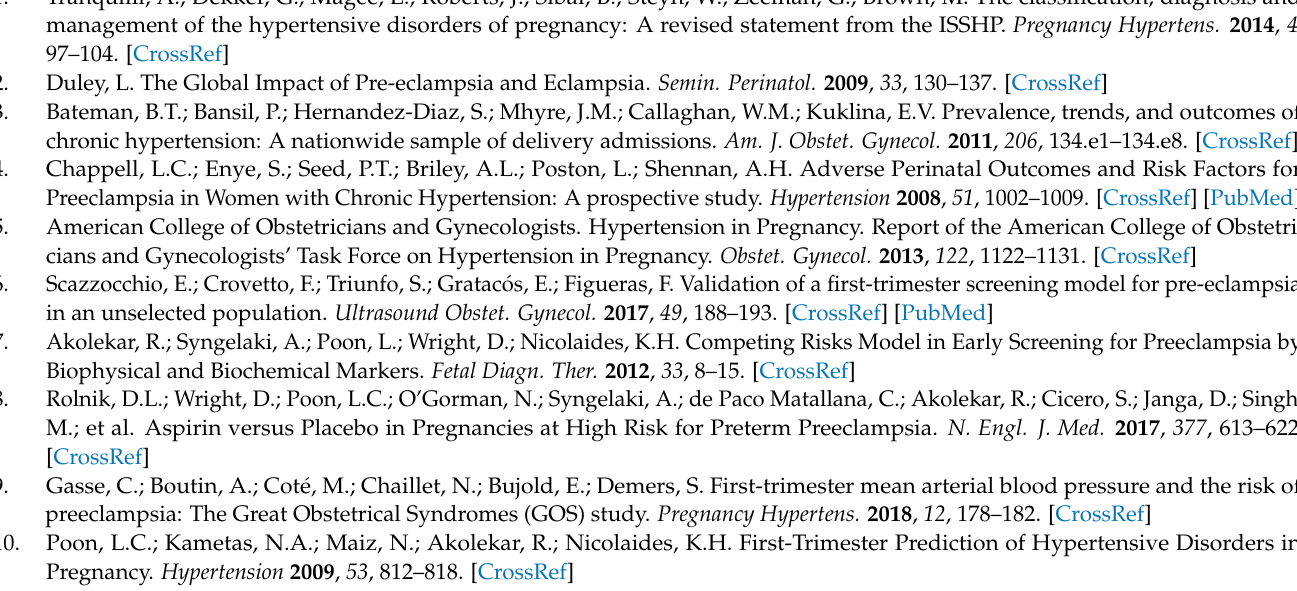
women. Table S2: Ambulatory pulse pressure values in the first trimester in normotensive and chronic hypertensive pregnant